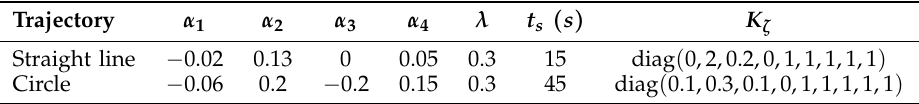
Table 5. Parameters for the proposed redundancy resolution